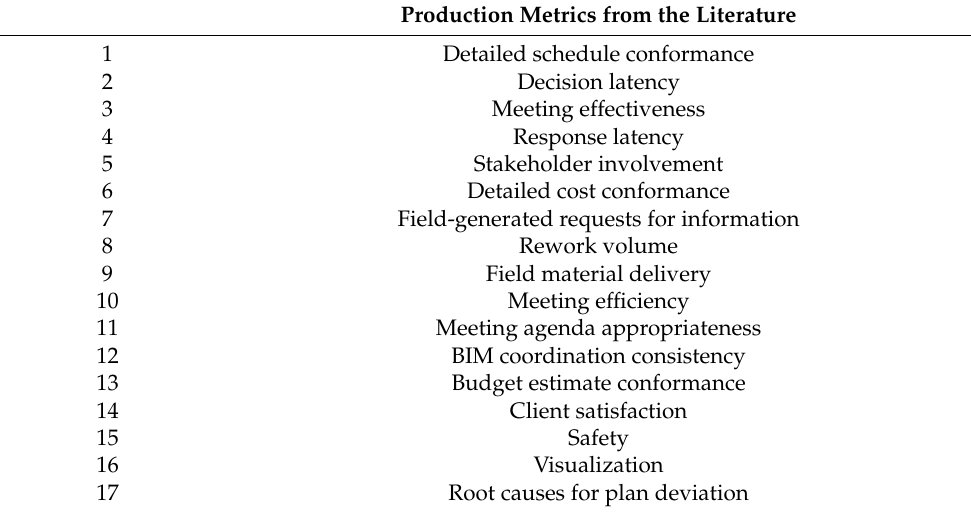
Table 2. List of production metrics, adapted from